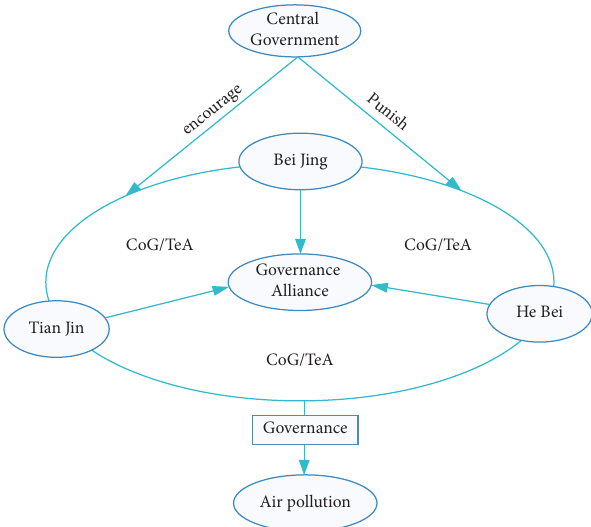
Figure 3: Decision-making framework on intergovernmental cooperative air pollution